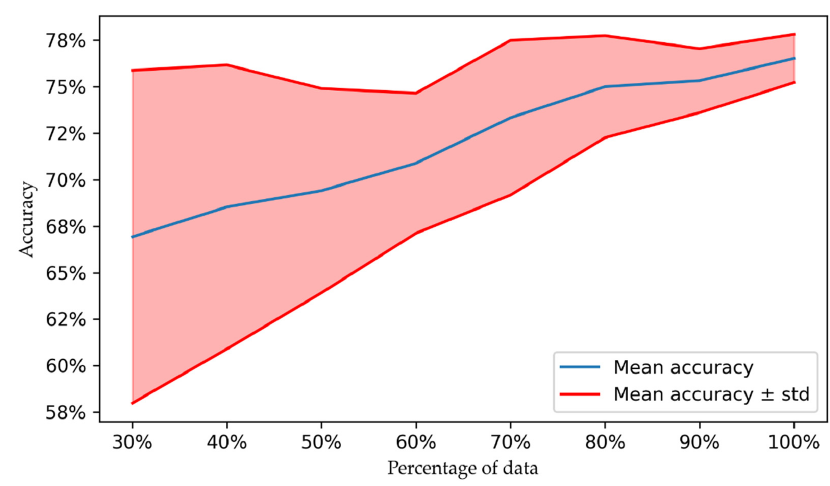
Figure 4. Model accuracy as a function of the dataset size.